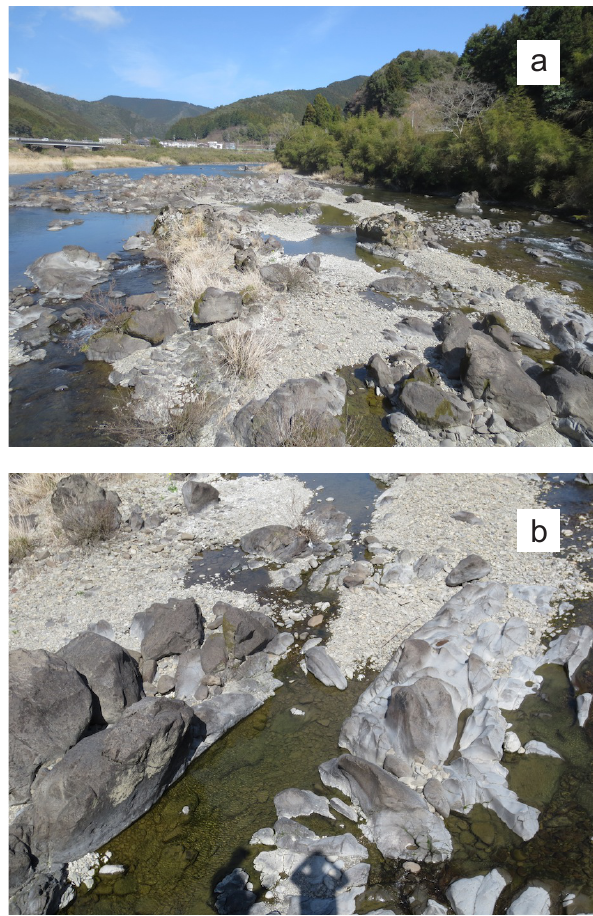
Figure 1. Views of the Shimanto River, a mixed alluvial–bedrock river in Shikoku, Japan. (a) Upstream view at low stage. (b) Macro- scopic roughness of the bed and alluvial patches. Channel width is about 100m.